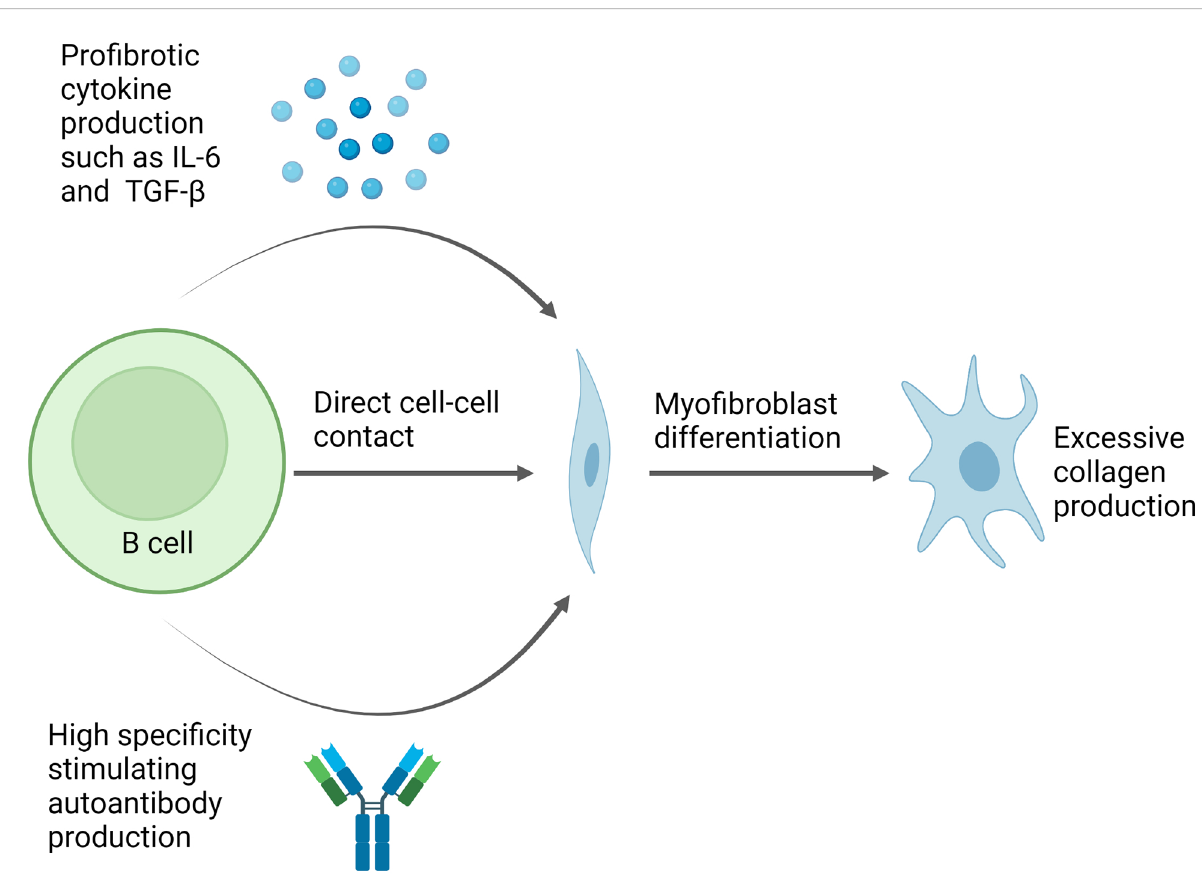
FIGURE 3 Potential pathway for B cell mediated fi brosis in scleroderma. Direct cell-cell contact can induce changes in gene expression in fi broblasts leading to increased collagen production and myo fi broblast differentiation. In addition, B cell production of cytokines such as IL-6 and TGF- b also induce myo fi broblast differentiation. Meanwhile, autoantibodies can form immune complexes which bind to fi broblasts and trigger pro- fi brotic effects, whilstsome autoantibody speci fi cities, such as PDGF, observed in a subset of SSc patients can bind fi broblasts directly and have stimulating effects. Figure created with